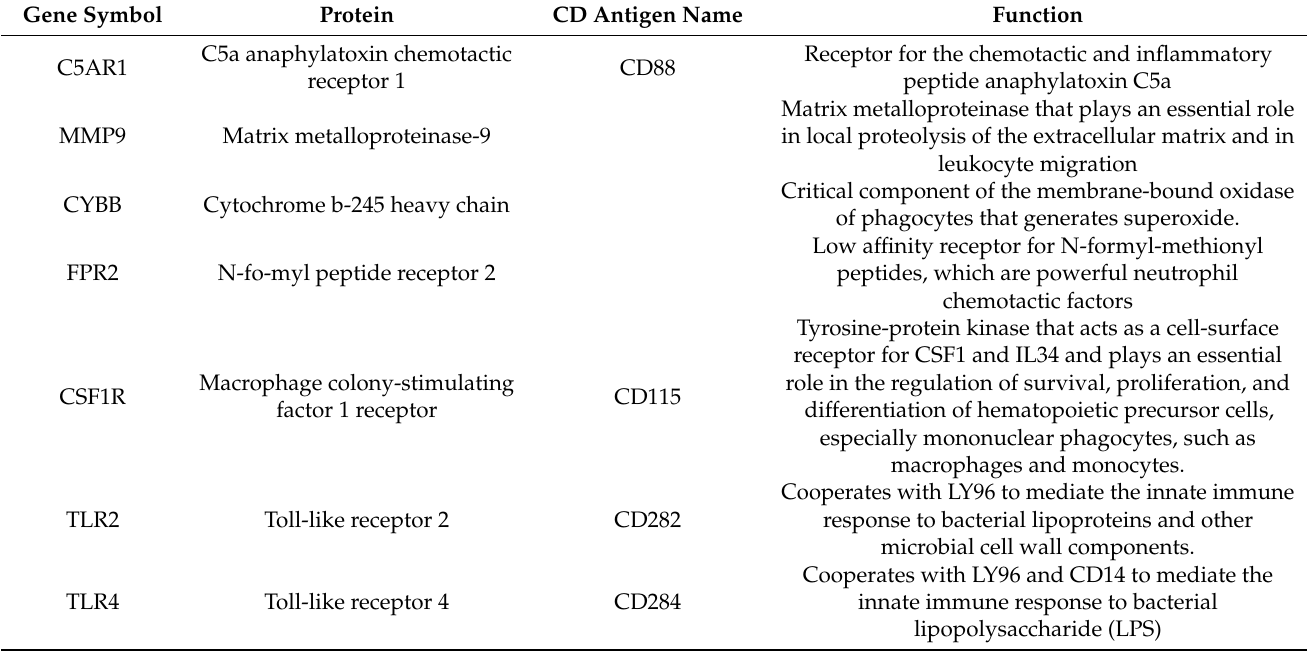
Table 2. Functional roles of immune-related hub